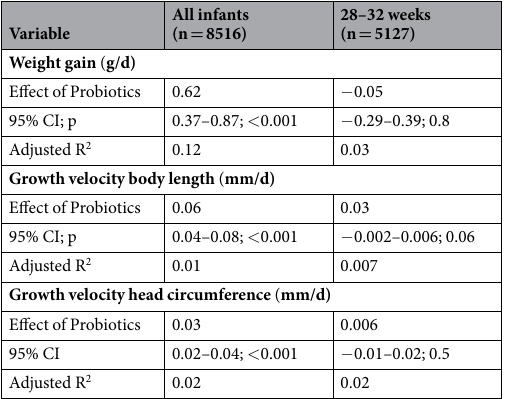
Table 2. Effect of probiotics on growth during primary stay in hospital. Linear regression analysis included gestational age per week, birth weight in 100 g steps, gender, multiple birth, maternal descent and exposure to Bifidobacterium infantis / Lactobacillus acidophilus probiotics. The effect of probiotics on weight gain as g/d growth rates in mm/d is shown as B coefficient, 95% confidence interval and p-value. Adjusted R 2 values indicate coefficients of determinations and adjust for the number of terms used in the model.